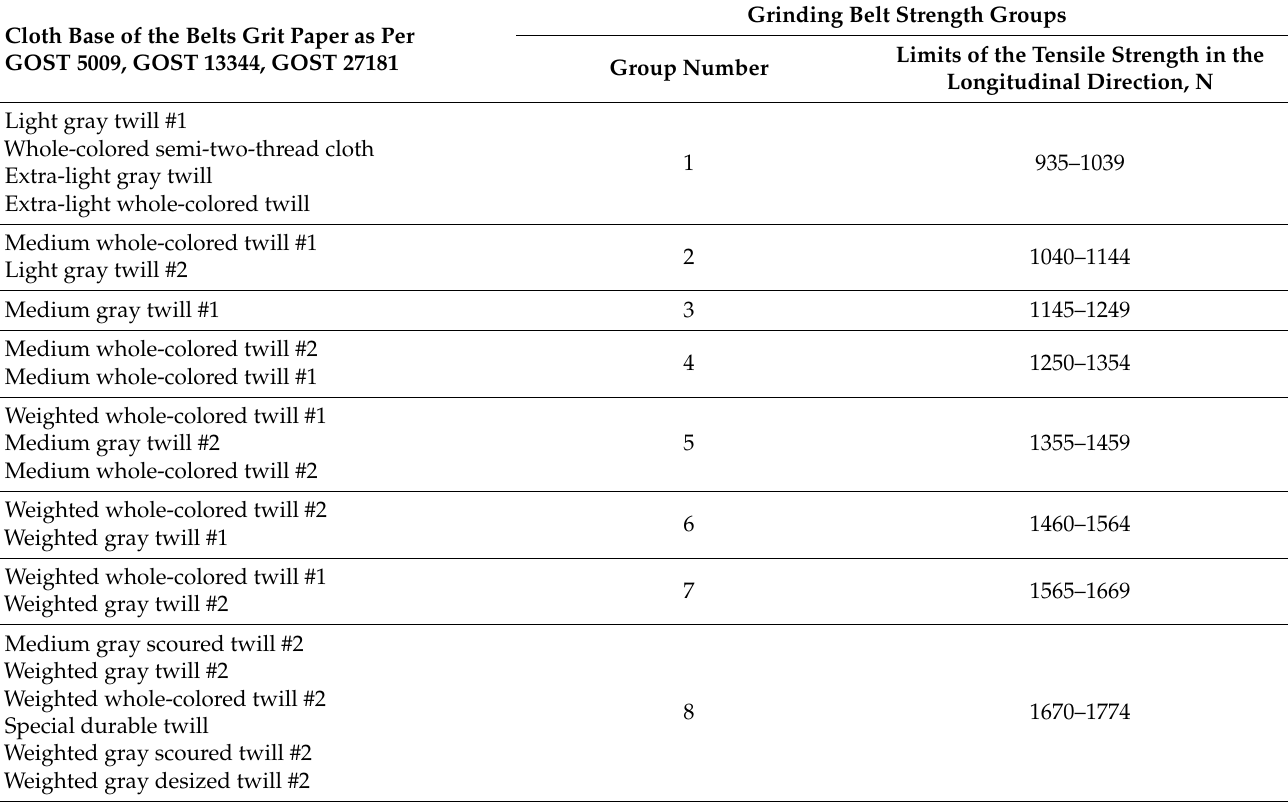
Table 7. Grinding belt strength groups used in the recommendations for setting the cutting